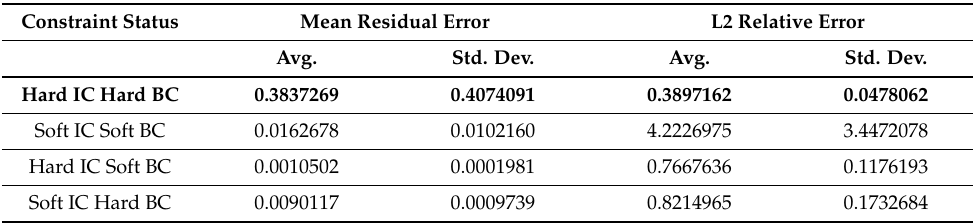
Table 1. Error evaluation of using the best experimental hyperparameters for hard initial and boundary constraints (hard–hard)